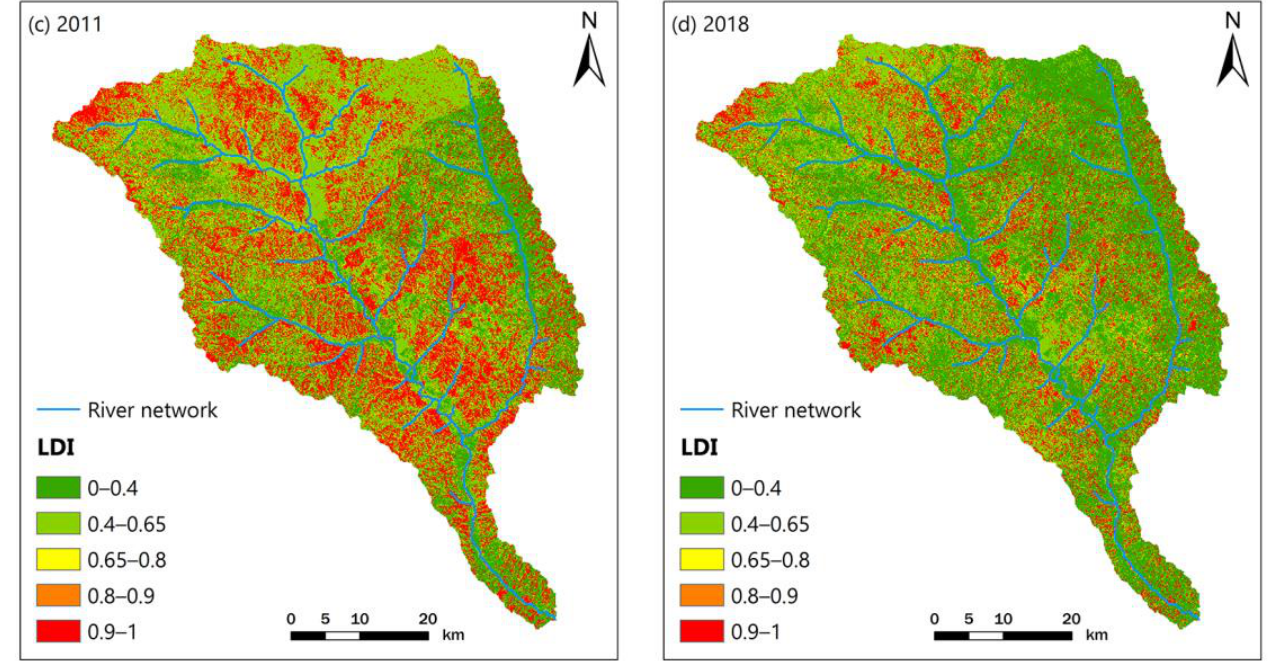
Figure 9. Land degradation index ( LDI ) changes in the Huangfuchuan watershed. ( a ) LDI map in 1990. ( b ) LDI map in 2000. ( c ) LDI map in 2011. ( d ) LDI map in